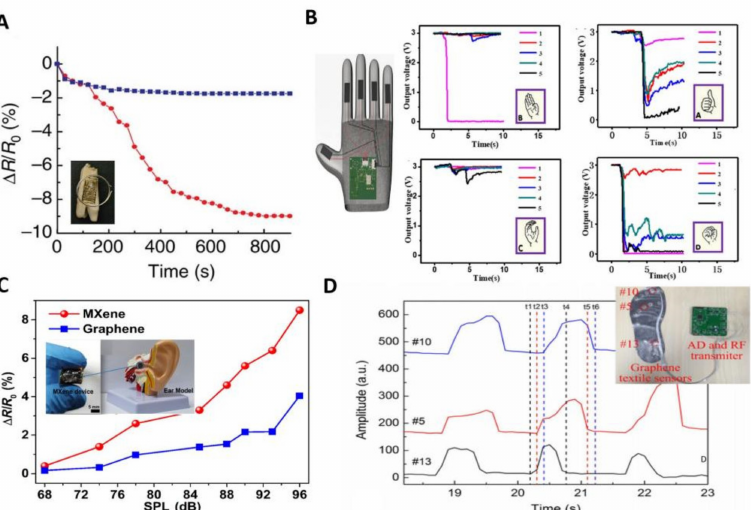
Figure 4. Several other wearable sensors based on 2D materials. ( A ): Percentage change in graphene resistance over time after exposure of the dental patch sensor to approximately 100 H. pylori cells in human saliva (red line). The response to a “blank” saliva solution is shown as a blue line [48]. Copyright 2012, Springer Nature. ( B ): Glove sensor for different schematics and the voltage output for different gestures [49]. Copyright 2021, Springer Nature. ( C ): Cochlear sensor resistance change with decibels; inset shows the MXene cochlear sensor [124]. Copyright 2021, Multidisciplinary Digital Publishing Institute. ( D ): Photograph of the foot sensor and comparison of the forces applied to each part(#5#10#13 in the illustration in the upper right corner correspond to the pressure sensors at differ- ent locations on the bottom of the three feet respectively.) [126]. Copyright 2017, Multidisciplinary Digital Publishing